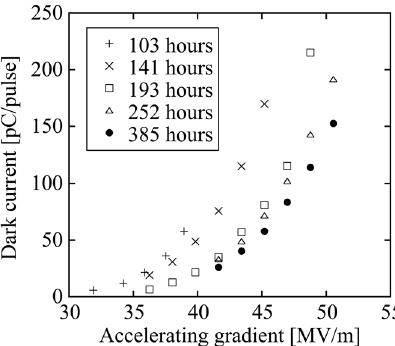
FIG. 12. Breakdown rate per day as a function of the accel- eration gradient. The solid circles and solid squares denote the breakdown rates at 256 and 370 h after the start of conditioning,